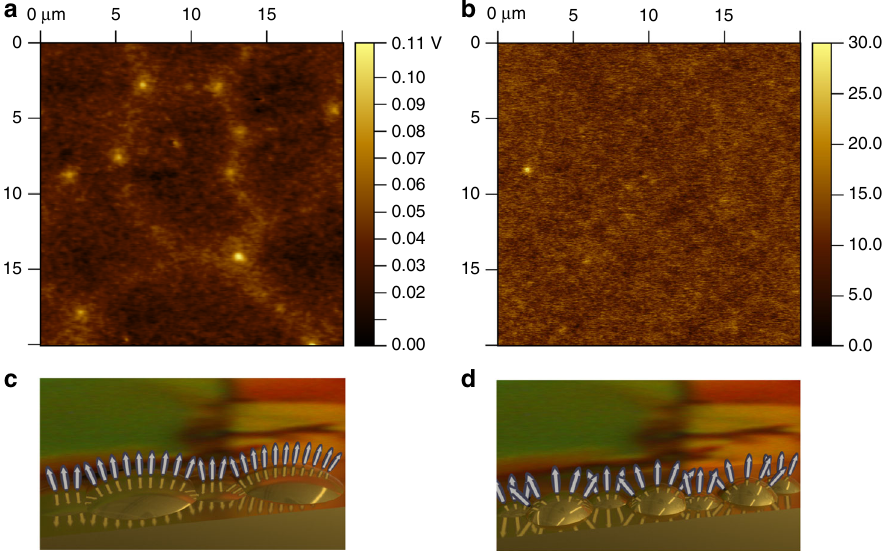
Fig. 5 SKPM measurements on PFBT/Au. a PFBT-treated Au deposited at 0.5 Ås − 1 showing small regions of higher surface potential. b PFBT-treated Au deposited at 2.5 Ås − 1 showing a more homogeneous surface potential distribution. c An illustration of the effect of large Au grains on the assembly of PFBT, depicted here as an arrow. d An illustration of small Au grains on the assembly of PFBT